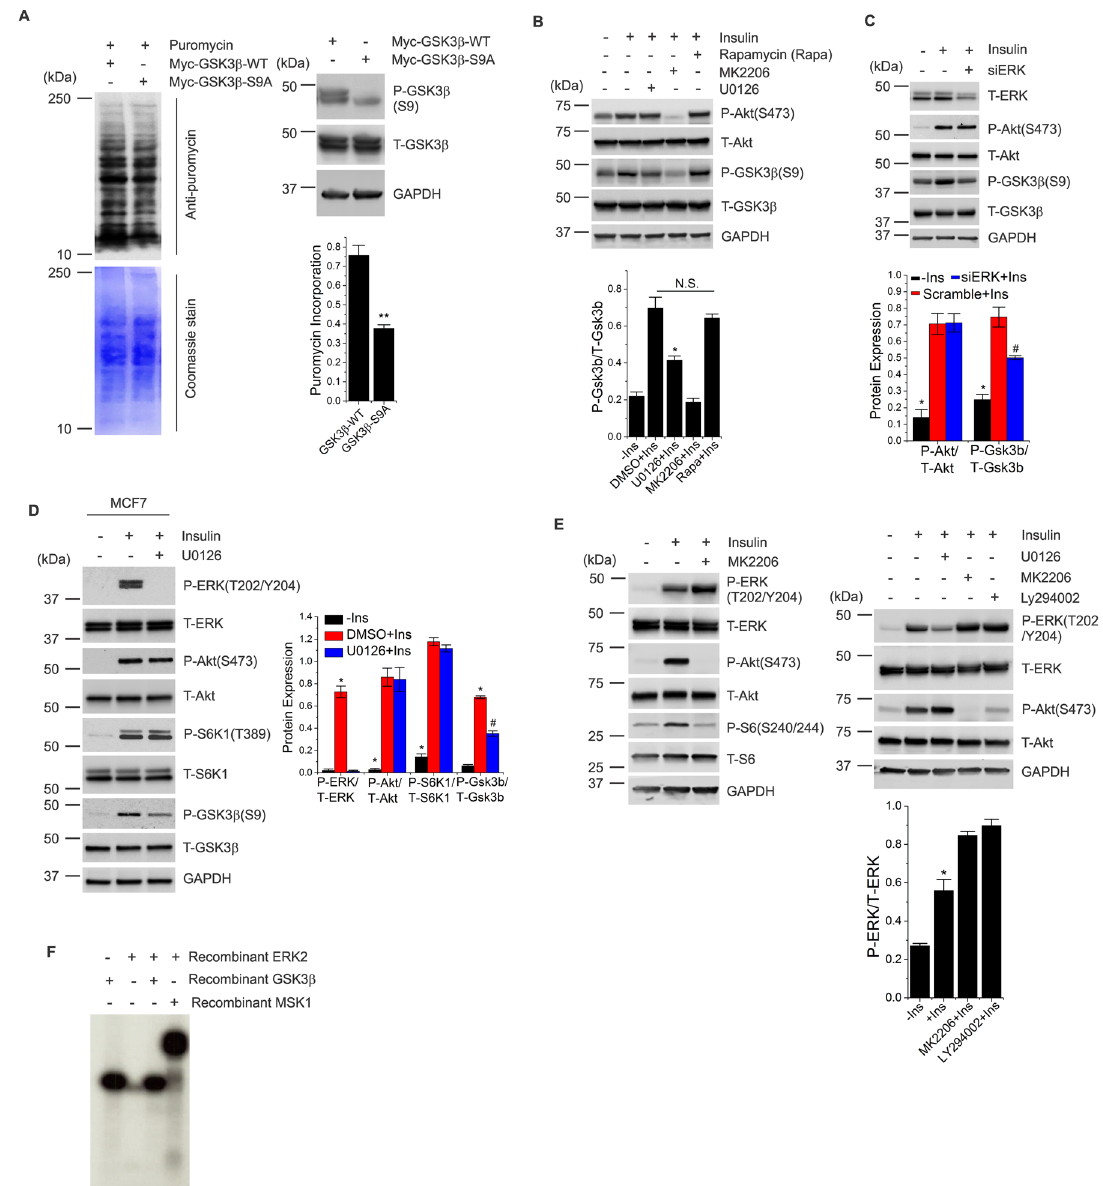
Figure 4. ERK integrates insulin signaling to GSK3 β in an Akt-independent manner. ( A ) HEK cells were transfected with Myc-GSK3 β -WT or Myc-GSK3 β -S9A for 48 h prior to the addition of puromycin in the culture medium. Cell lysates were probed with an antibody to puromycin. The blot was stained with coomassie at the end of the immunoblot assay. Another set of cells were transfected with Myc-GSK3 β -WT or Myc-GSK3 β -S9A for 48 h prior to cell lysis. Lysates were probed with antibodies as indicated. ( B ) HEK cells were starved of serum (16 h) and treated with the indicated drugs for 2 h prior to insulin stimulation (1 µ M, 15 min). Lysates were analyzed by immunoblot assay using antibodies as indicated. Quantification of three independent experiments is reported in the bar diagrams. * indicates significant differences between all conditions in each group. ( C ) HEK cells transfected with siERK or scramble for 56 h prior to 16 h-serum starvation followed by insulin stimulation (1 µ M, 15 min) where indicated. Lysates were probed with antibodies as indicated. Quantification of three independent experiments is reported in the bar diagrams. * and # indicate significant differences between all conditions in each group. ( D ) MCF7 cells were treated as in B prior to the cell lysis. Cell lysates were analyzed with antibodies as indicated. Quantification of three independent experiments is reported in the bar diagrams. * and # indicate significant differences between all conditions in each group. ( E ) HEK cells were starved of serum and treated with the indicated drugs for 2 h prior to insulin stimulation. Lysates were analyzed by immunoblot assay using antibodies as indicated. ( F ) In vitro kinase assay (see method for complete details). Quantification of three independent experiments is reported in the bar diagrams. * Indicates significant differences between all conditions in each group. GAPDH was used as a loading control in all immunoblot assays. All quantitative analyses are reported as mean ± SEM with a significance level of * p < 0.05, ** p < 0.01 and # p < 0.05. N.S. indicates not significant. Cropped blots from full-length gels are displayed in